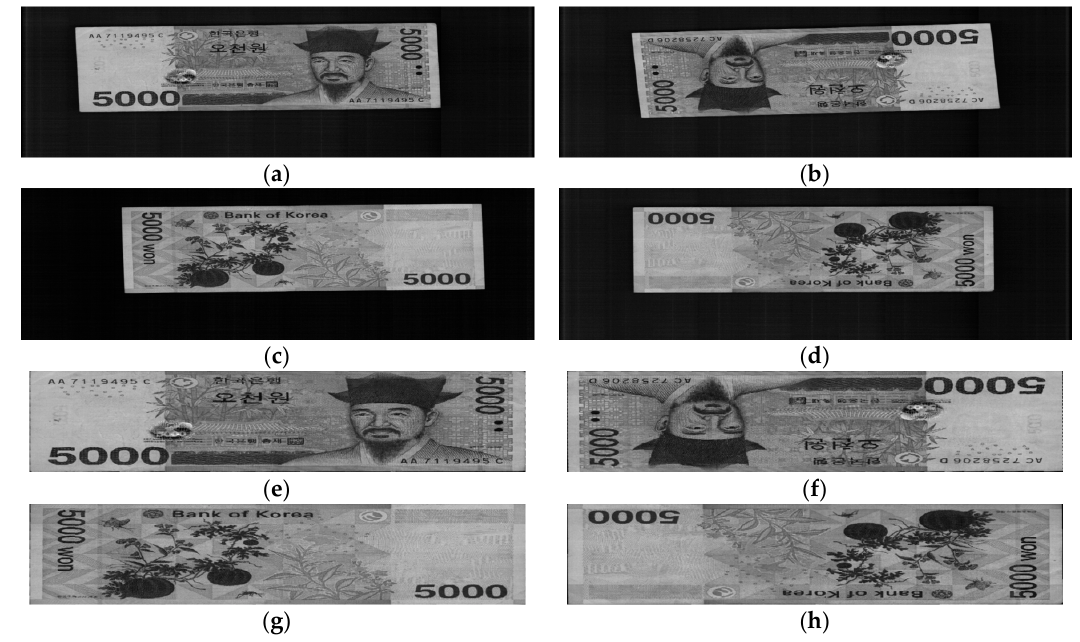
Figure 2. Example of input banknote images in four directions: Original captured banknote image in ( a ) A direction; ( b ) B direction; ( c ) C direction; ( d ) D direction; ( e – h ) Corresponding banknote region segmented from the images in ( a – d ), respectively.